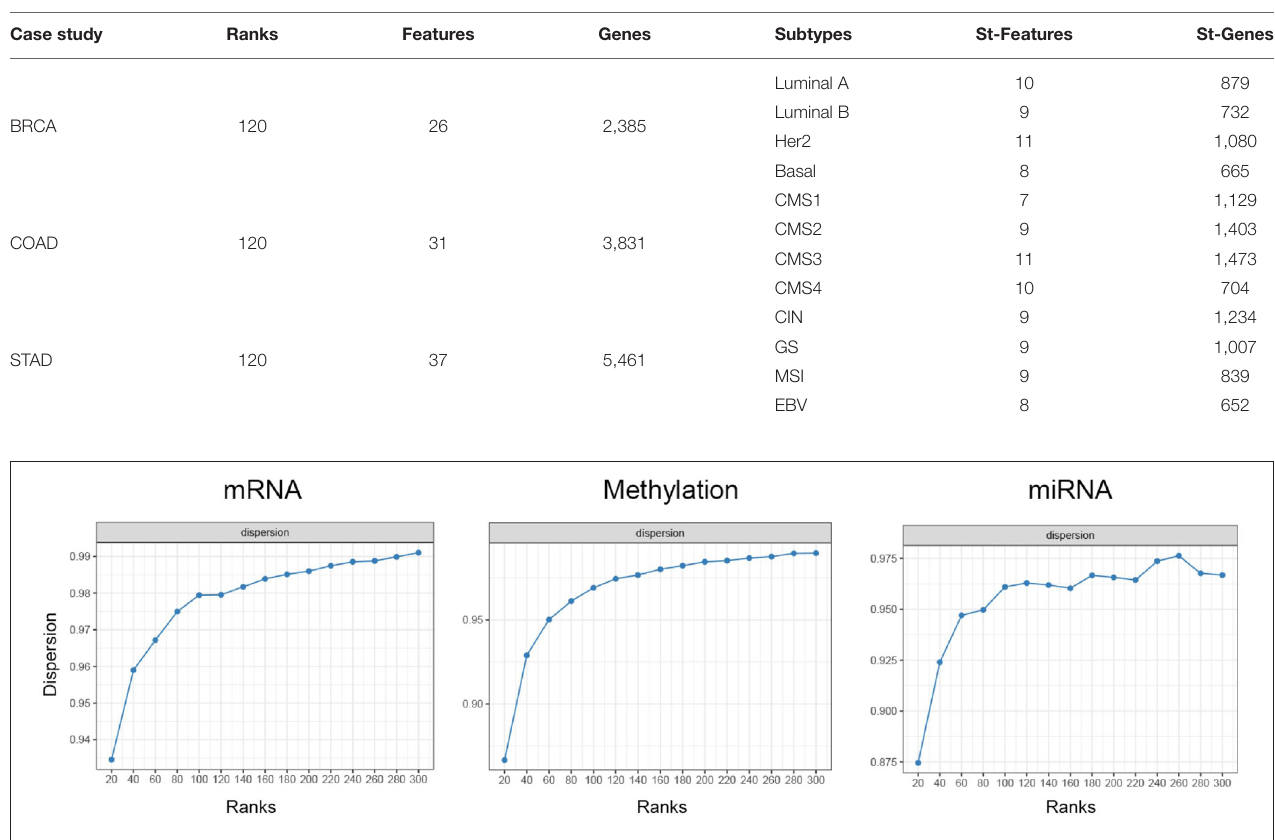
FIGURE 8 | The dispersion plot using different ranks using BRCA omics data for estimating optimal NMF